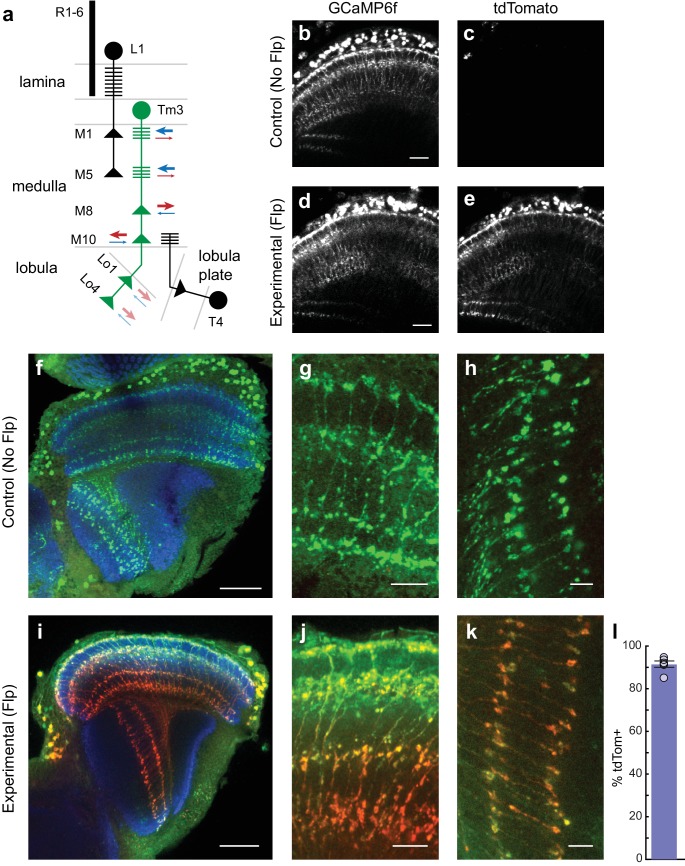
cacFlpStop ND inverts efficiently in Tm3 neurons, and cell type-specific loss of Cac does not disrupt cell morphology.(a) Schematic of the transmedulla visual neuron Tm3 (green) and selected local circuitry. In the lamina neuropil, R1-6 photoreceptors synapse onto L1, which in turn provides input onto Tm3 in medulla layers M1 and M5. Tm3 synapses onto the direction-selective neuron T4 in layer M10. The arrows depict the relative fraction of input (blue) and output (red) synapses at each Tm3 arbor, with heavier weights indicating a larger contribution. Darker arrows represent connections identified by EM reconstruction (Takemura et al., 2013). Lighter arrows are hypothesized synaptic contributions based on Syt-HA labeling (Hasegawa et al., 2011). (b–e) In vivo expression of GCaMP6f (b and d) and tdTomato (c and e). In (b and c) a control lacking Flp (no-Flp control) is shown (full genotype: cacFlpStop ND/Y; +/UAS-GCaMP6f; Tm3 R13E12-Gal4/tubP-Gal80ts), and in (d and e) an experimental animal is shown (full genotype: cacFlpStop ND/Y; UAS-Flp/UAS-GCaMP6f; Tm3 R13E12-Gal4/tubP-Gal80ts). One-photon excitation was used. Images are maximum intensity projections of 6 μm z-stacks. Scale bars are 20 μm. (f–k) Confocal images of the visual system from no-Flp control (f–h) and experimental (i–k) flies. GCaMP6f is labeled in green (anti-GFP), tdTomato is labeled in red (anti-dsRed), and the neuropil is labeled in blue (anti-Bruchpilot). (f and i) Full optic lobes. (g and j) Tm3 arbors in medulla layers M1, M5, M8, and M10. (h and k) Arbors in lobula layers Lo1 and Lo4. Images are maximum intensity projections of ~5–10 μm z-stacks. Scale bars are 30 μm in (f and i), 10 μm in (g and j), and 5 μm in (h and k). (l) Bar plot displays the percentage of GCaMP6fpositive Tm3 neurons that are also labeled by tdTomato. The bar is the mean, the error bars are ±1 SEM, and the dots are the values for each individually scored visual system. N visual systems = 6, N cells scored = 467.